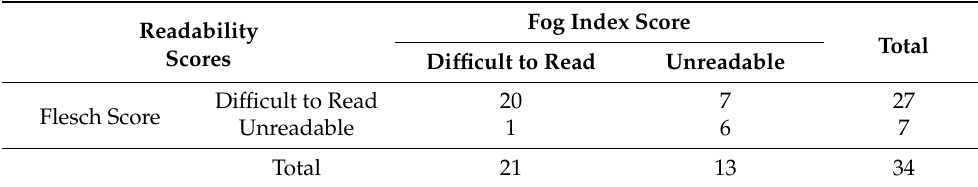
Table 9. Contingency table for McNemar change